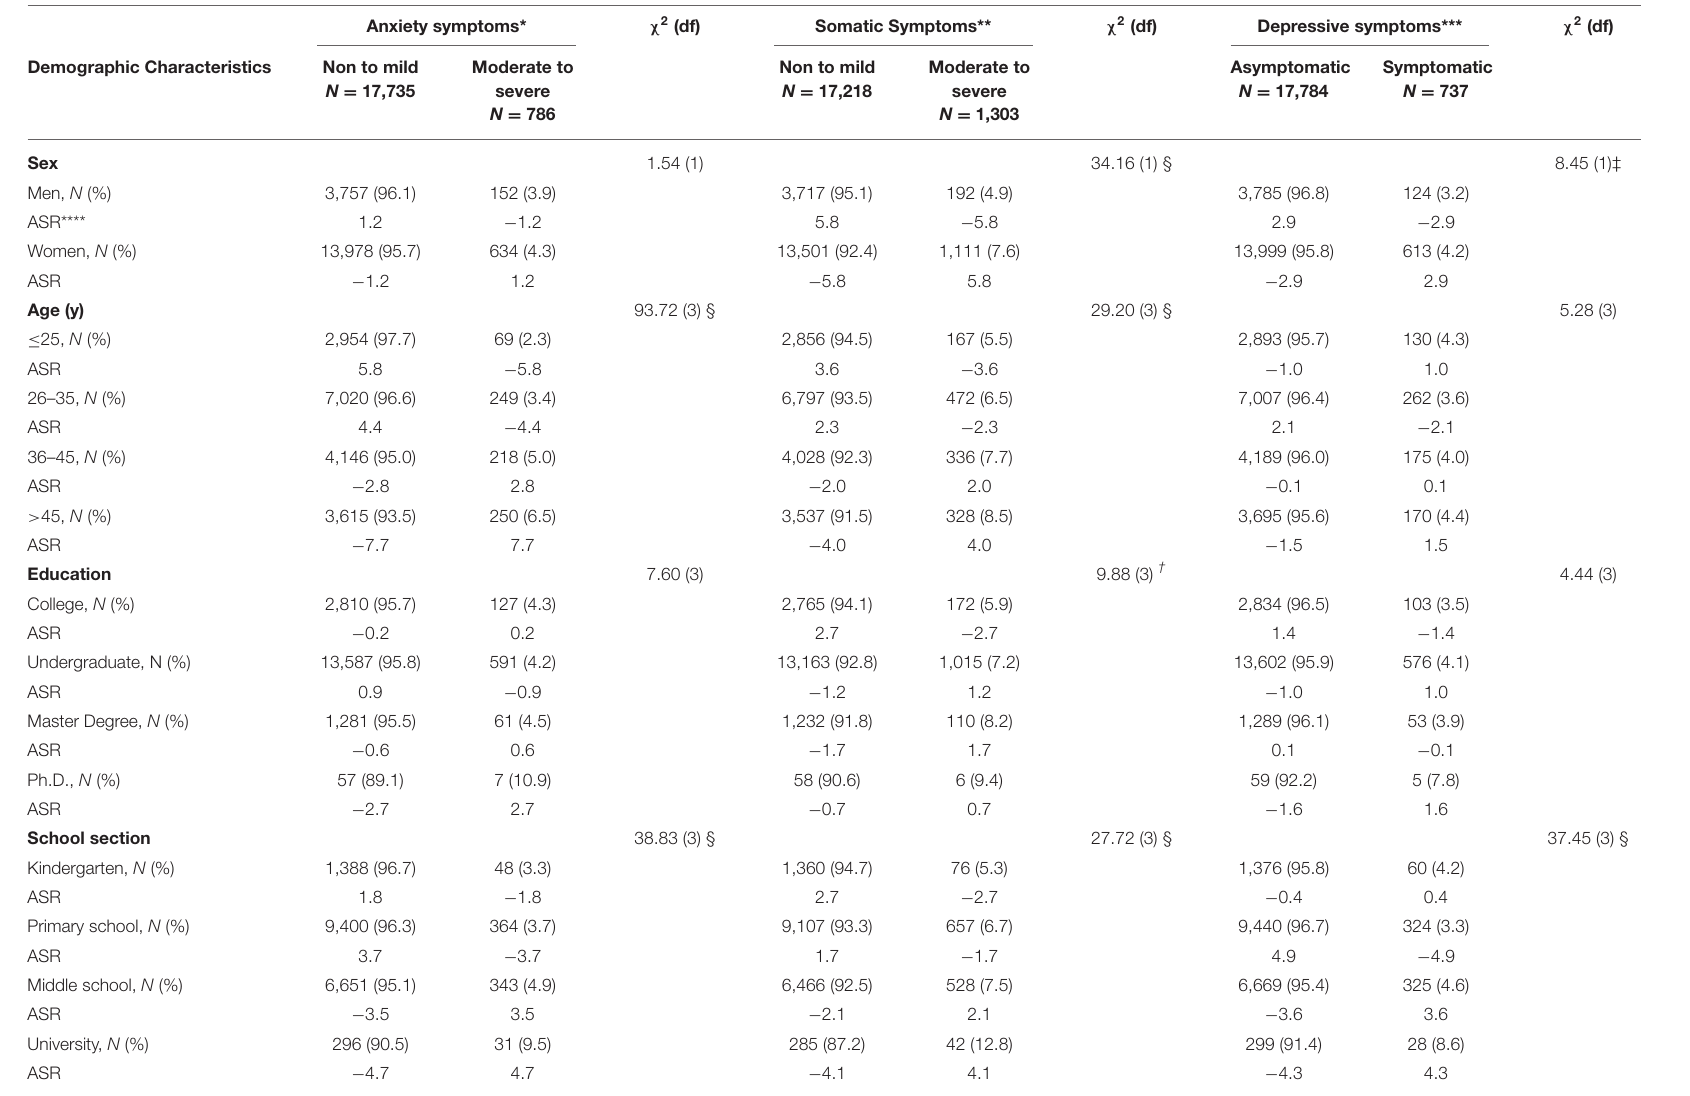
TABLE 2 | Demographic and GAD-7, PHQ-15, PHQ-2, Chi-square analysis. Anxiety symptoms* χ 2 (df) Somatic